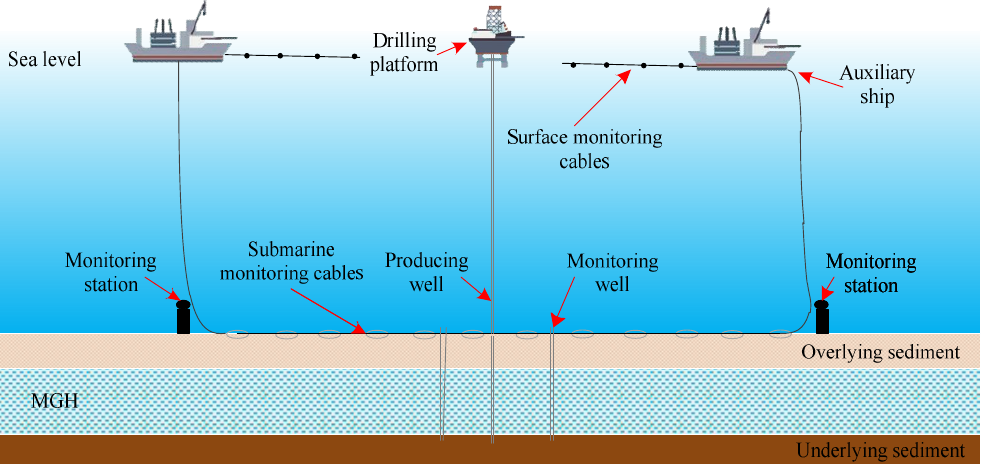
Figure 13. Submarine in-situ monitoring system [67].